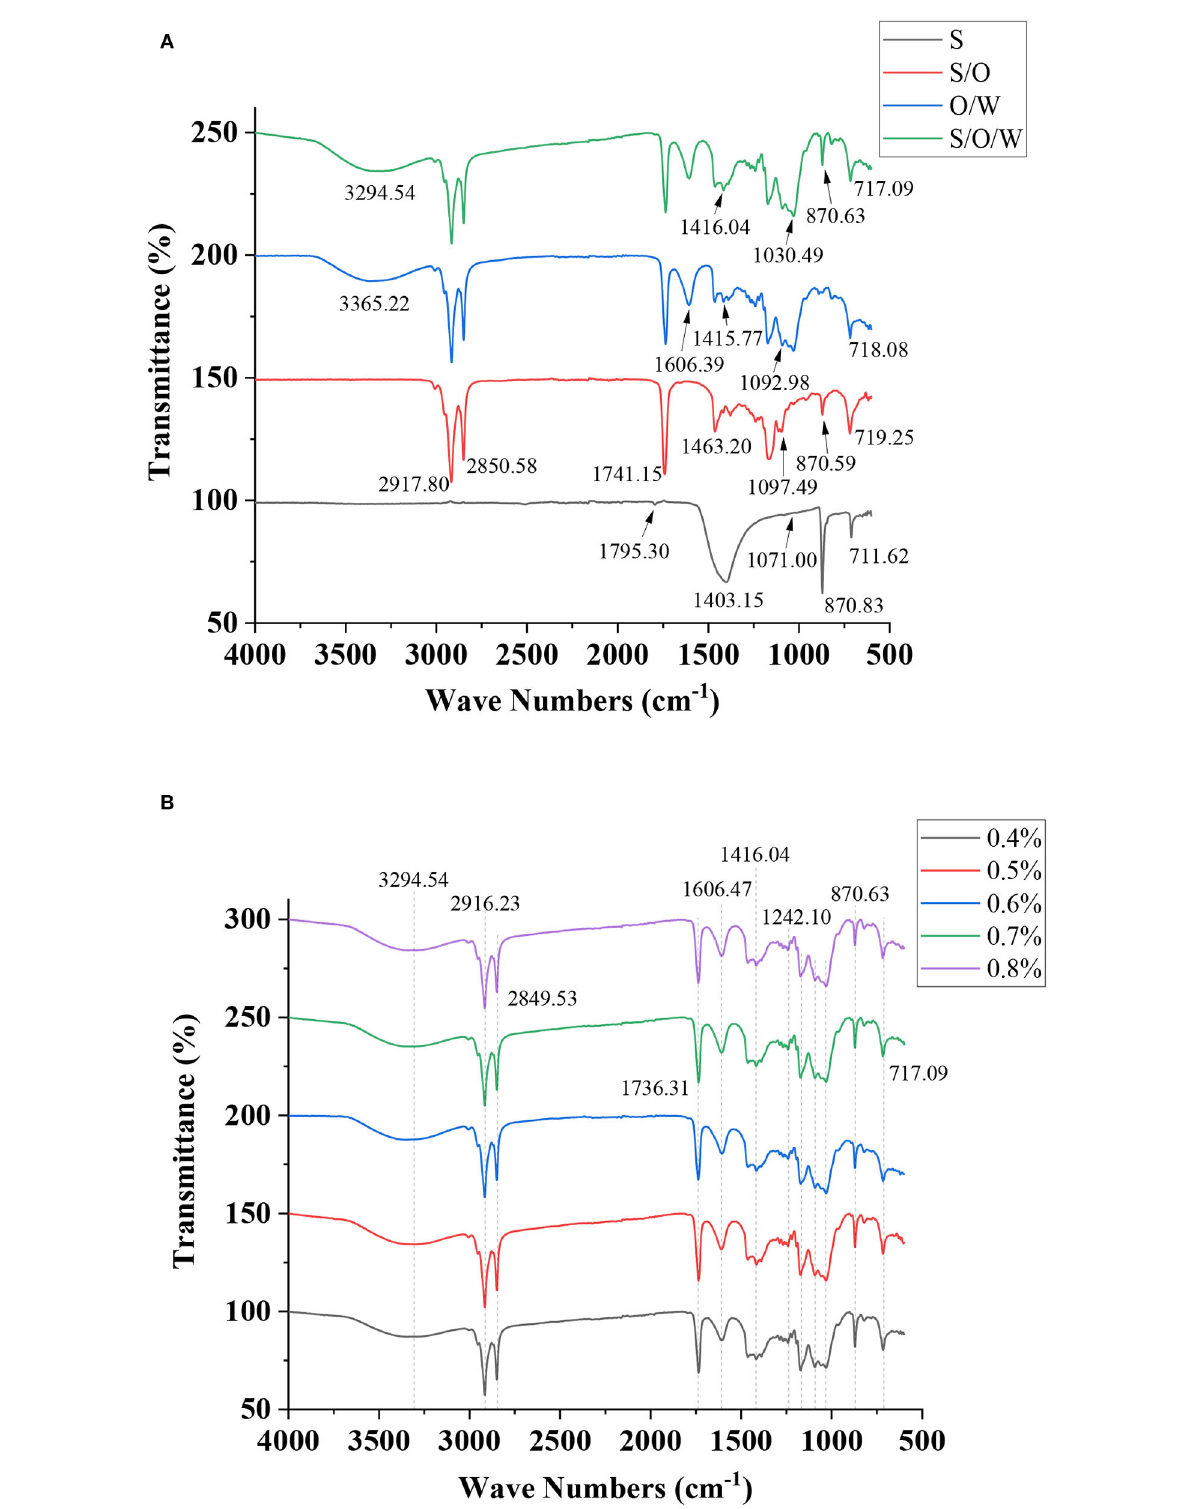
FIGURE6 Fourier transform infrared (FTIR) spectra of (A) CaCO 3 powders, S/O phase, O/W emulsion without CaCO 3 , S/O/W calcium-lipid emulsion, and (B) S/O/W calcium-lipid emulsions formed by different concentrations of PGA-XG